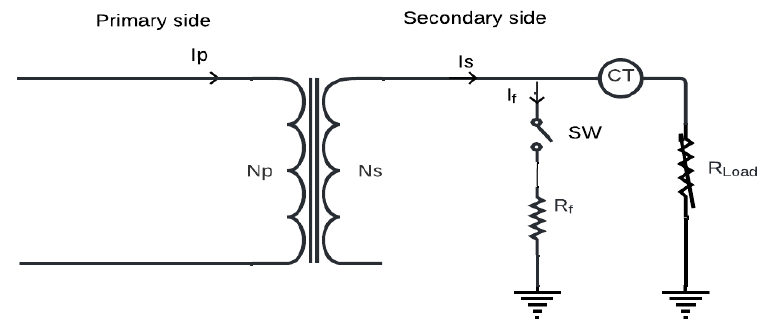
Figure 5. Single phase-to-ground fault representation.